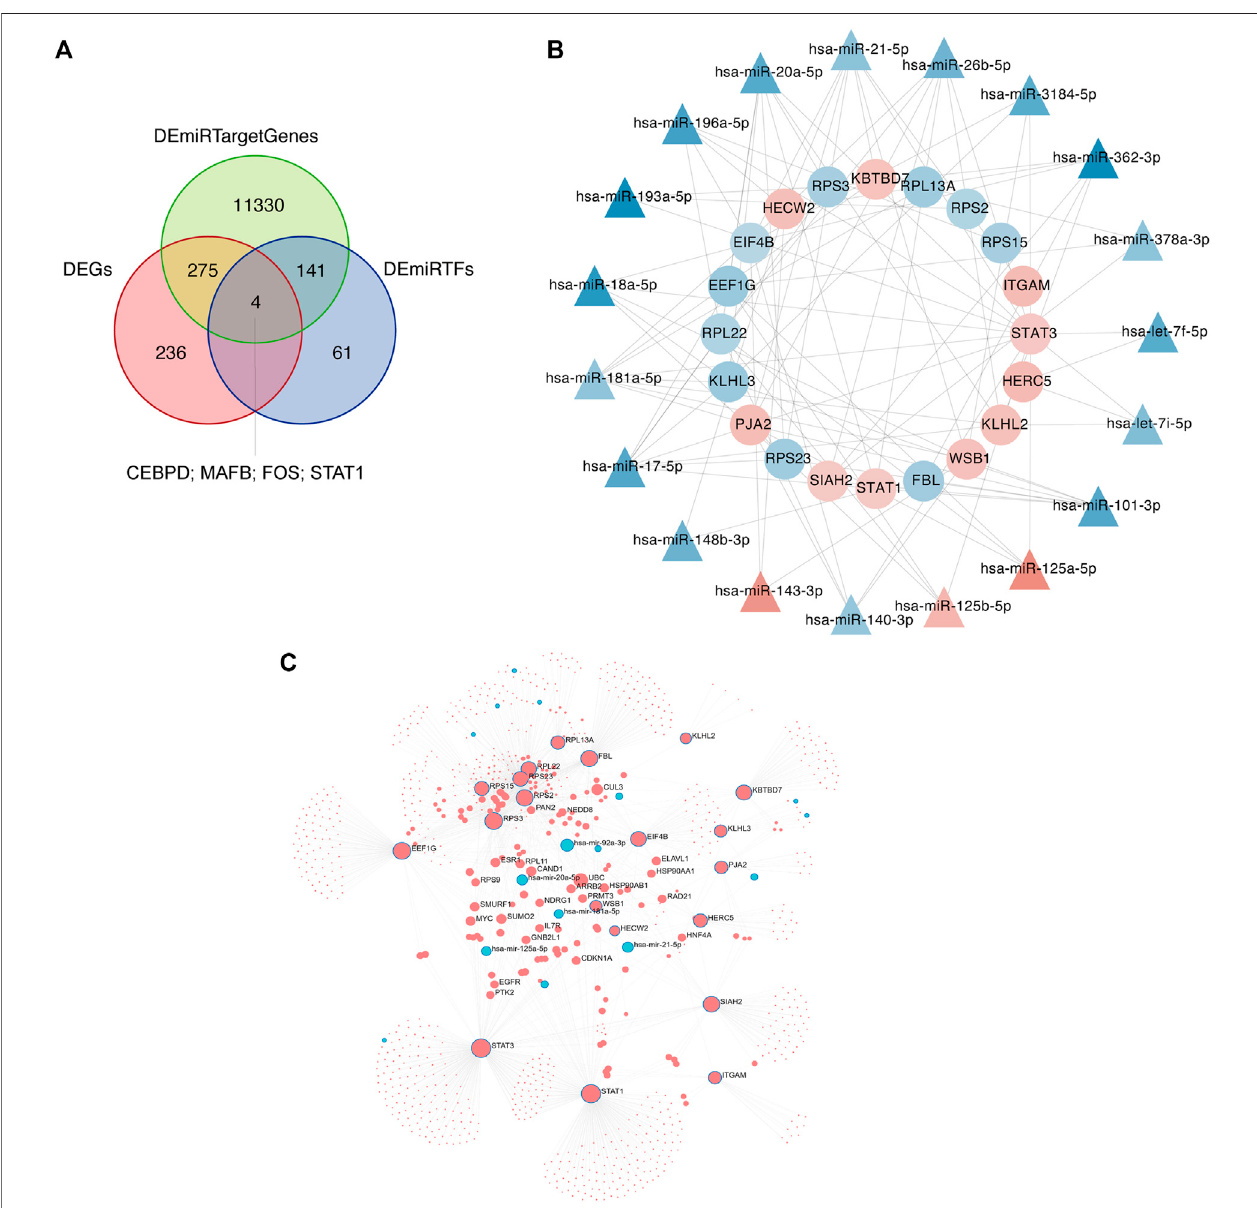
FIGURE 13 | Network analyses of target genes and transcription factors. (A) The intersection of differentially expressed genes (DEGs), differential miRNA target genes, and transcription factors is determined using Venn diagram analysis. (B) Intersection molecules-miRNA network analysis. The inner ring is the intersection of DEGs and DEmiRTargetGenes, and the outer ring is miRNAs. Red indicates increased expression, blue indicates reduced expression, and color intensity indicates different degrees of upregulation or downregulation. (C) Network diagram of differential lncRNAs, miRNAs, and mRNAs. Red indicates upregulated expression; blue indicates downregulated